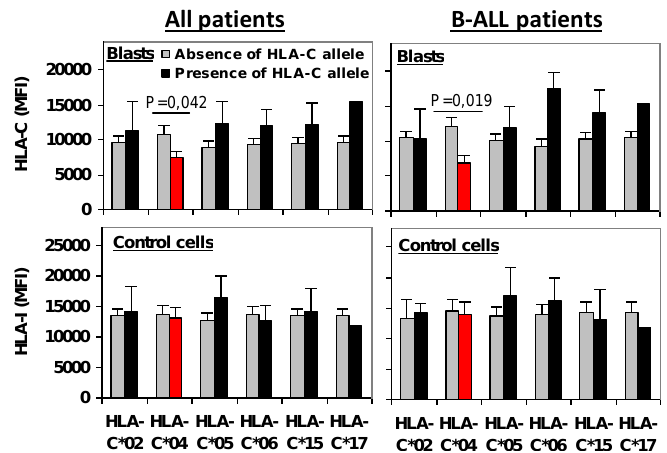
Figure 5. Loss of HLA-C expression was selectively observed in patients carrying the HLA-C*04 allotype. HLA-C and HLA-I expression on leukemic blast cells and on control cells in total acute leukemia patients and B-ALL patients carrying HLA-C allotypes with the C2-epitope. p estimated with Student ’s t-test.